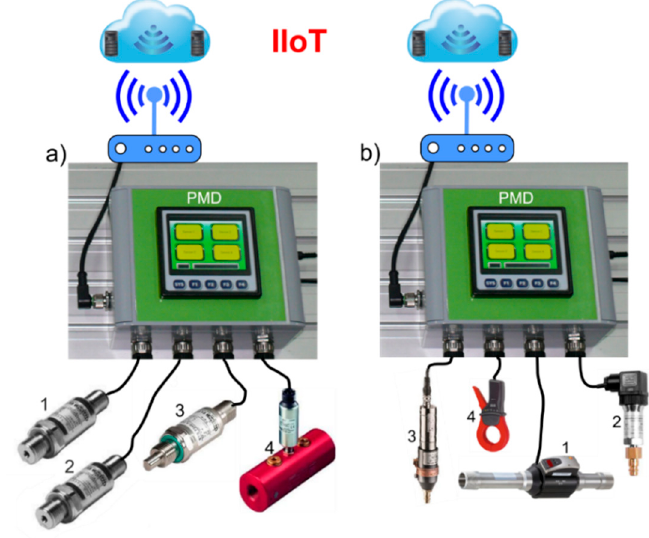
Figure 1. Two PMD measurement sets: ( a ) for diagnostics of hydraulic systems: 1—pressure sensor, 2—pressure sensor, 3—temperature sensor, 4—flow meter, ( b ) for monitoring of compressed air systems: 1—flow counter, 2—pressure sensor, 3—temperature sensor, dew point sensor, 4—clamp-on ammeters.